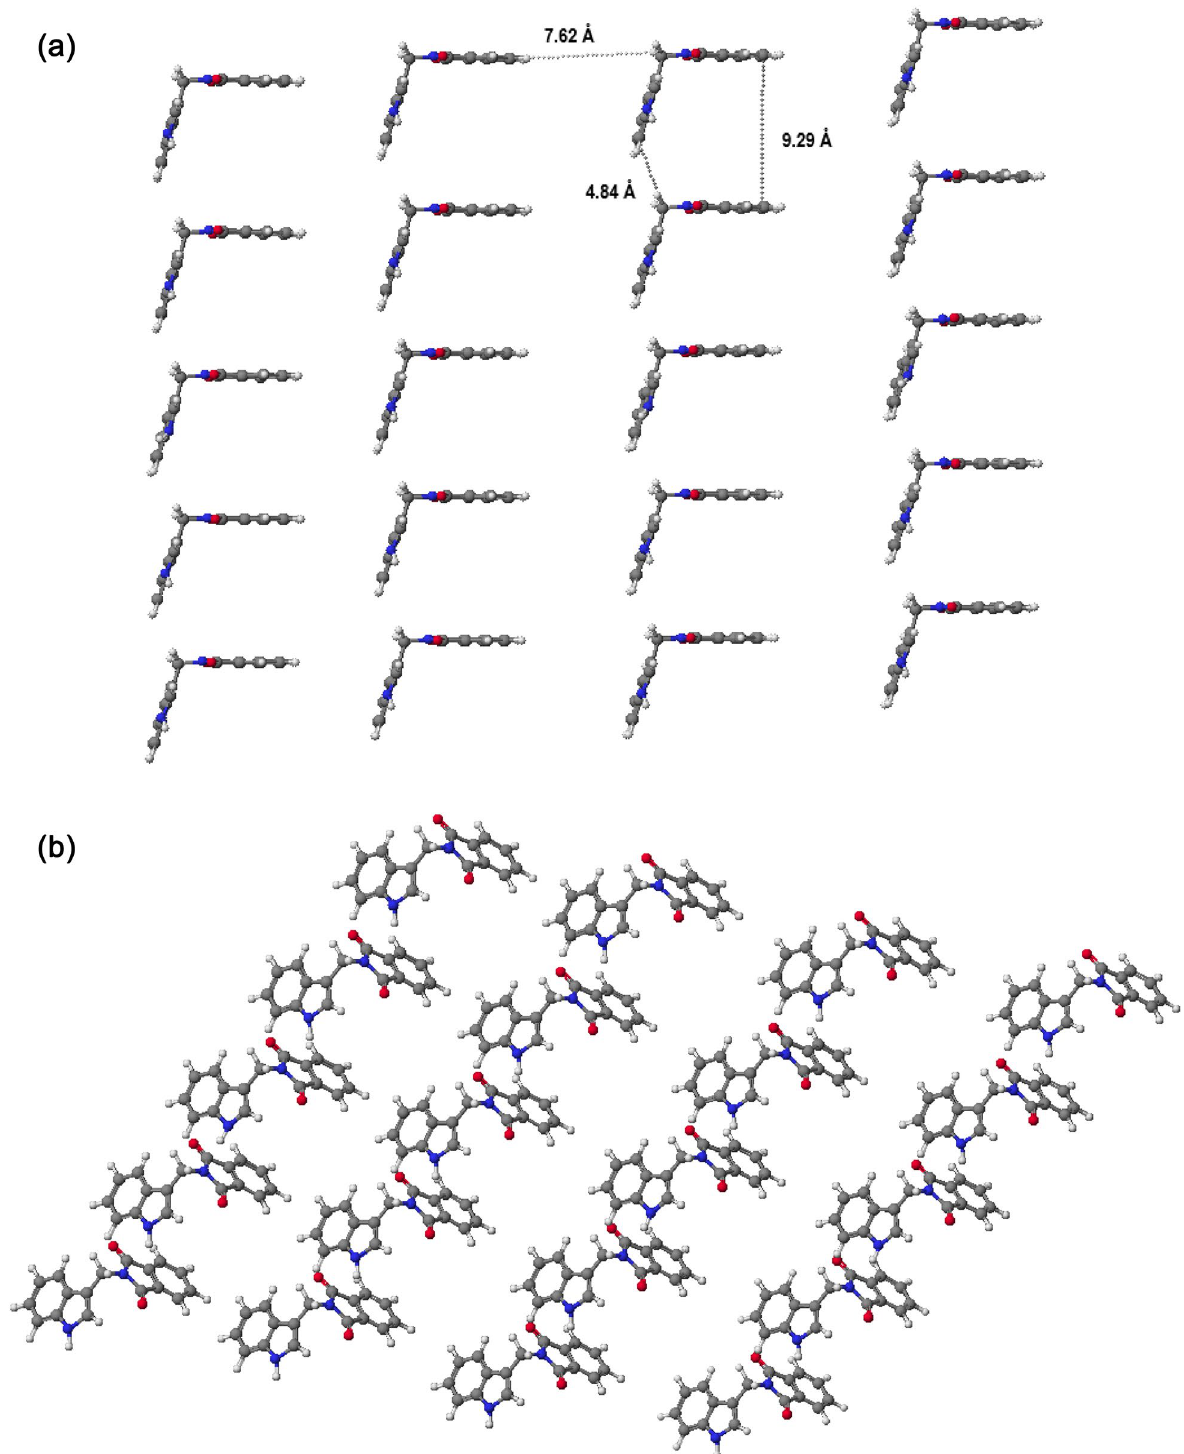
Figure 7. Molecular models of derivative 14 calculated by PM 5 method for twenty molecules in two different perspectives: side view ( a ), top view ( b ) (WinMopac 2003) 39